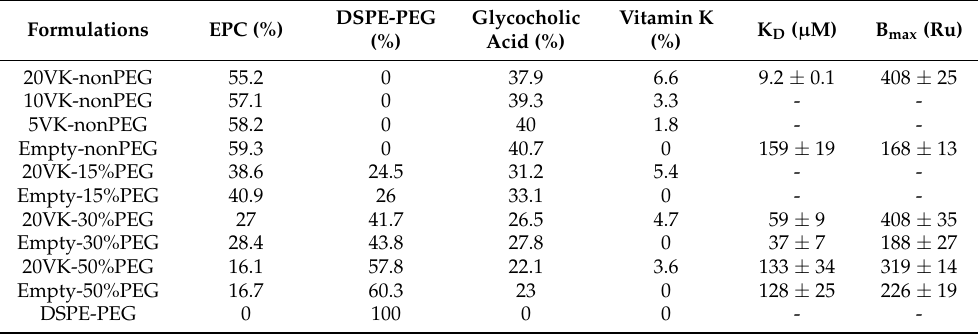
Table 2. Compositions in weight percentages of the micelles used for SPR analysis, and the corre- sponding K D and B max (mean ± SD, n =